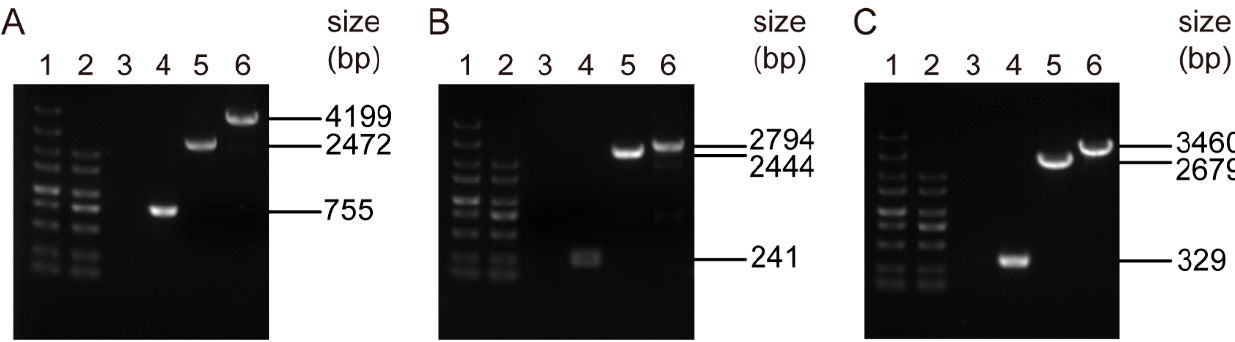
Figure 5. PCR identification of the mutants. ( A ) ∆ pmtA ; ( B ) ∆ perR ; ( C ) ∆ lysR . Lanes 1 and 2 indicate the DL5000 and DL2000